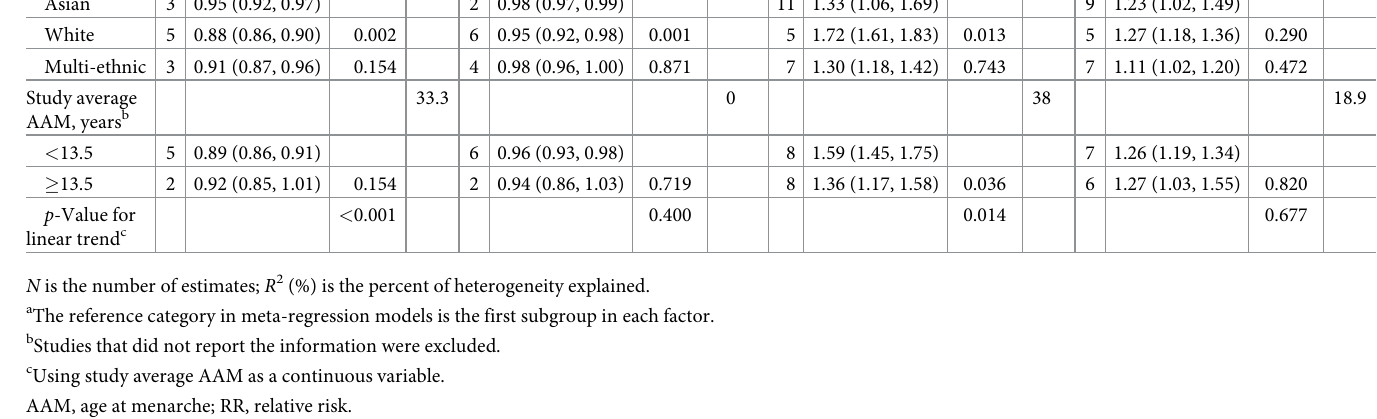
Table 3. Univariable meta-regression results ( R 2 and p -values) and pooled RR for diabetes and impaired glucose tolerance in study subgroups. Factor and